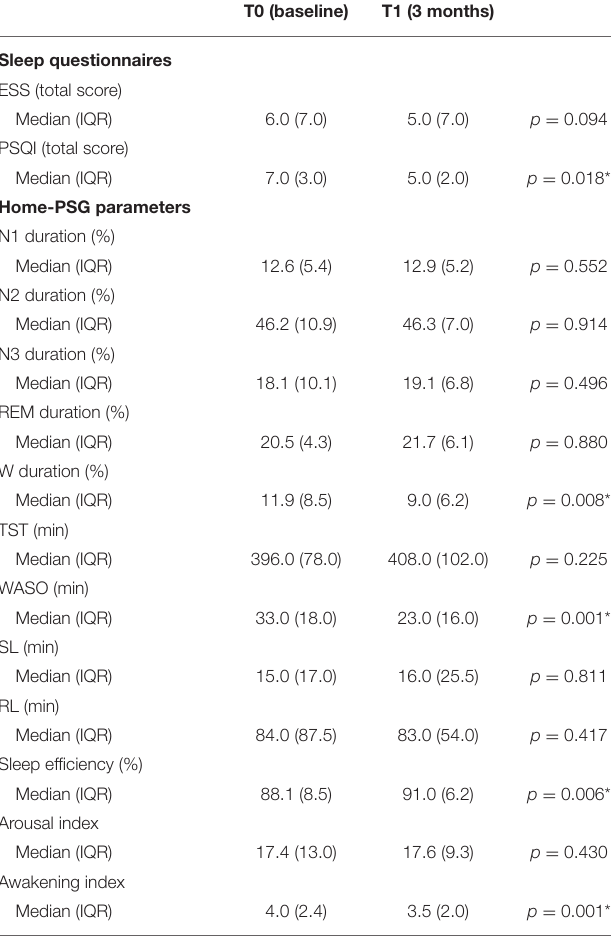
TABLE 5 | Results of sleep questionnaires and home-polysomnography recordings at baseline and after 3 months of treatment with erenumab ( n = 29). T0